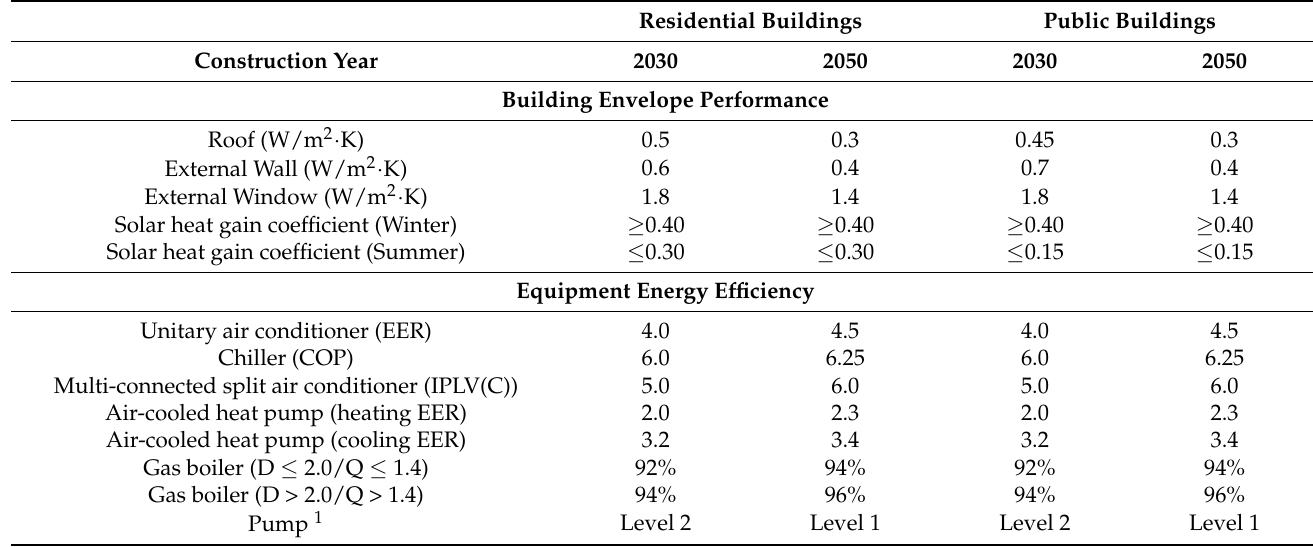
Table 5. Energy conservation measures for buildings.